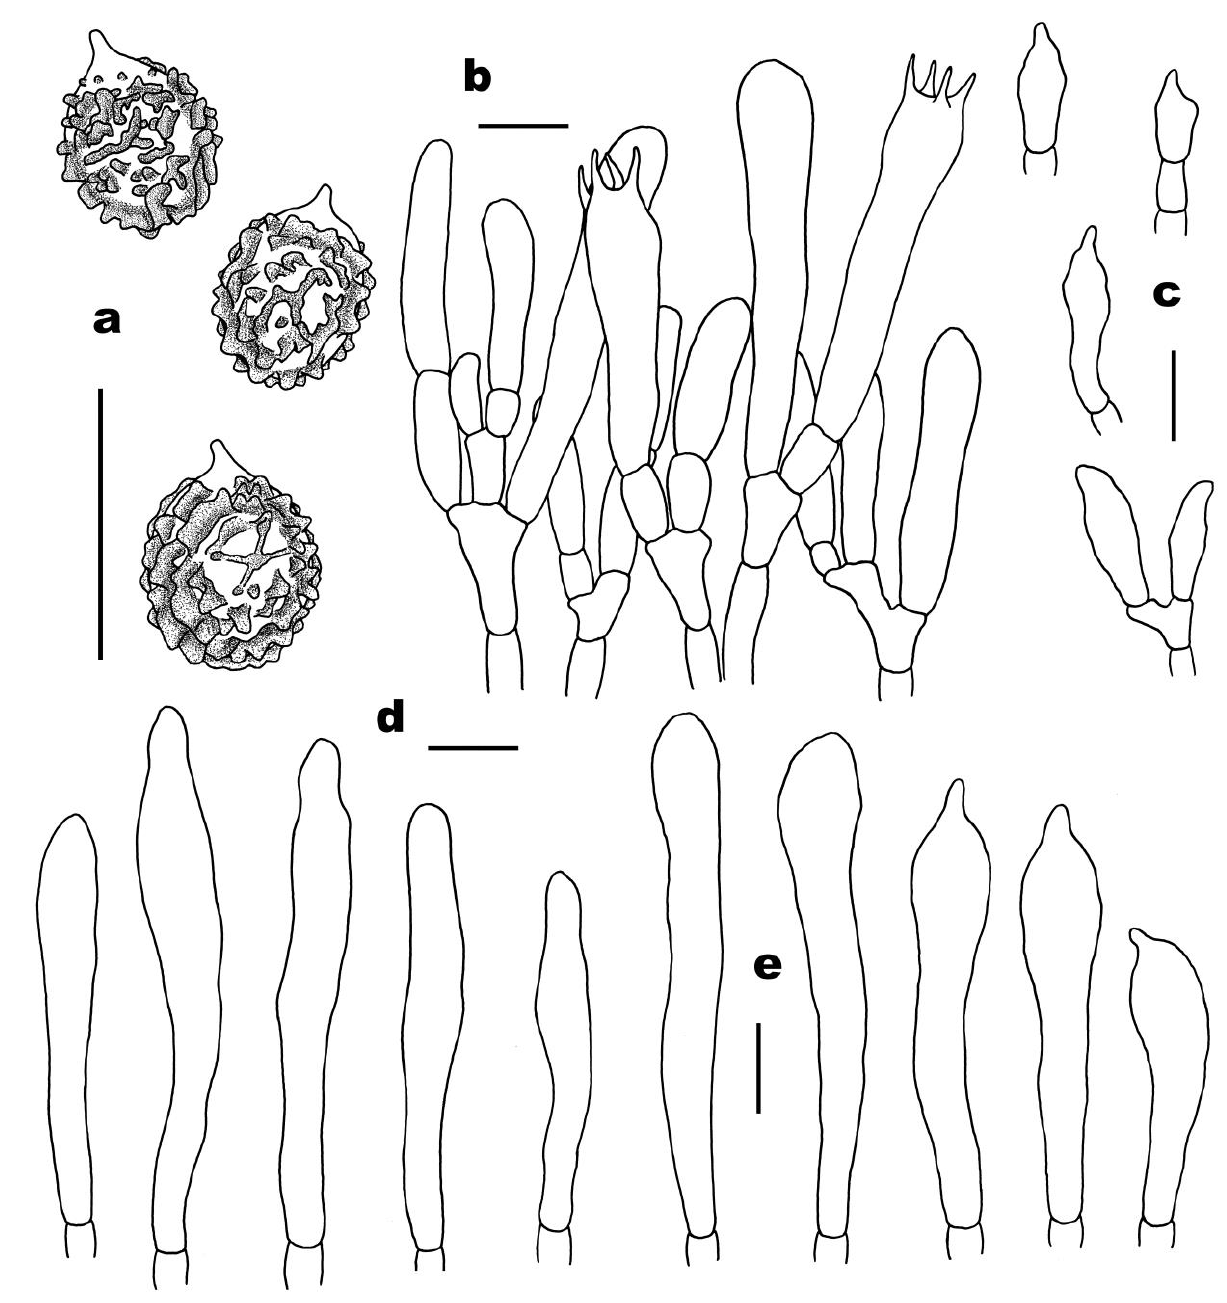
Figure 8. Microscopic features of Russula rufobasalis (FHMU827). ( a ) Basidiospores. ( b ) Basidia and basidiola. ( c ) Marginal cells. ( d ) Pleurocystidia. ( e ) Cheilocystidia. Bars: 10 μm. Drawings by Y.X. Han.